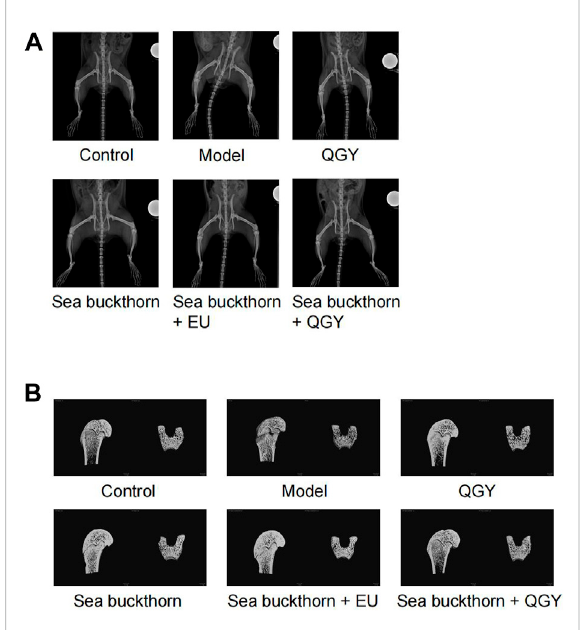
FIGURE 1 X-ray images of the rat hip and 3D images of the region of interest of the femur. (A) X-ray images showing the rat hip. (B) 3D images of the region of interest of the